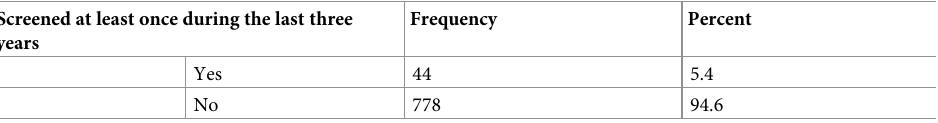
Table 5. Utilization of cervical cancer screening among women (n = 822) in Debremarkos town, Northwest Ethio- pia, 2018. Screened at least once during the last three